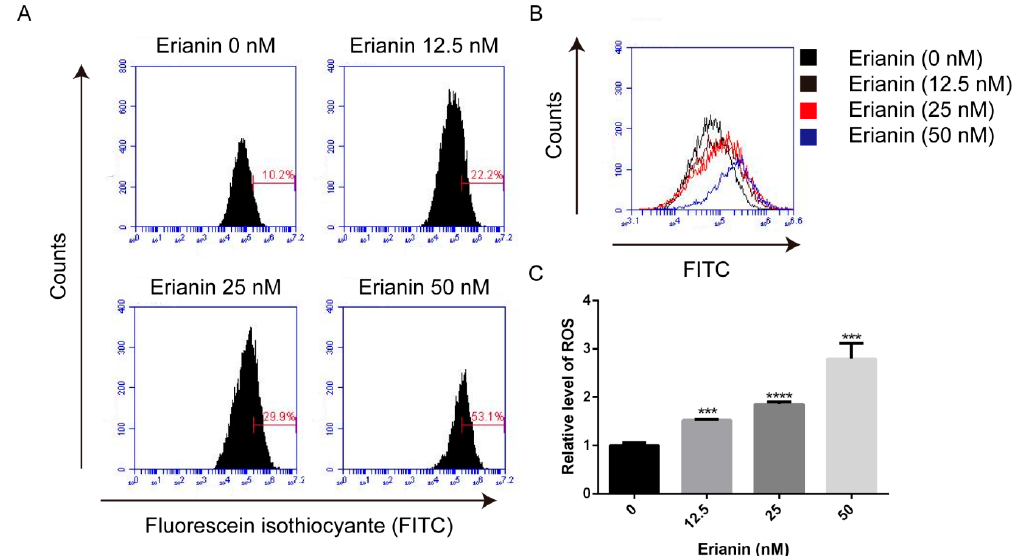
Figure 3. Erianin-induced reactive oxygen species (ROS) production in HaCaT cells. Cells were treated with various concentrations of erianin (12.5 nM, 25 nM and 50 nM) for 24 h. ( A ) Fluorescent intensity was analyzed by flow cytometry. ( B ) Representative images of ROS production. ( C ) The mean fluorescence intensity was normalized to the untreated group. The values are expressed as mean ± SD ( n = 3). *** p < 0.005, **** p < 0.001, significantly different compared with the untreated group.